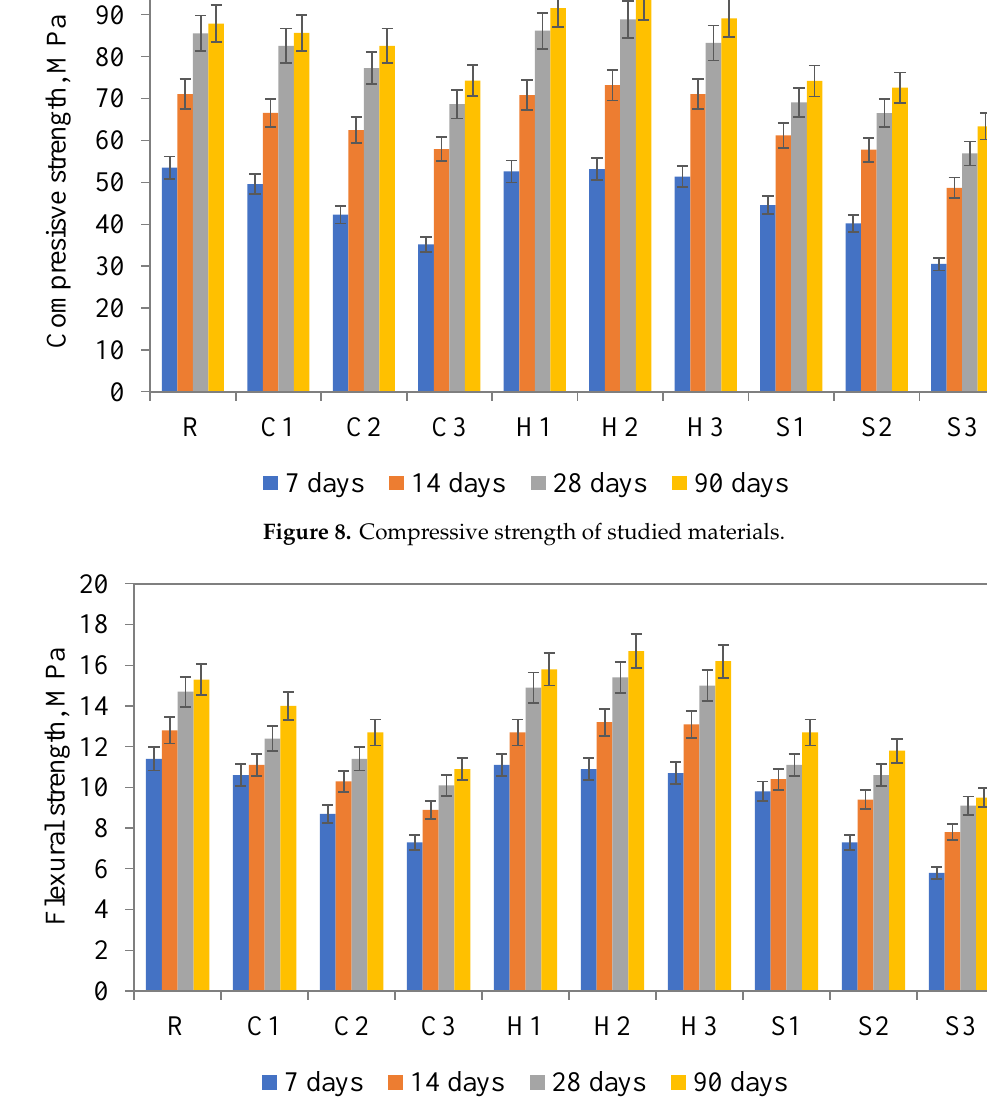
Figure 9. Flexural strength of studied materials.